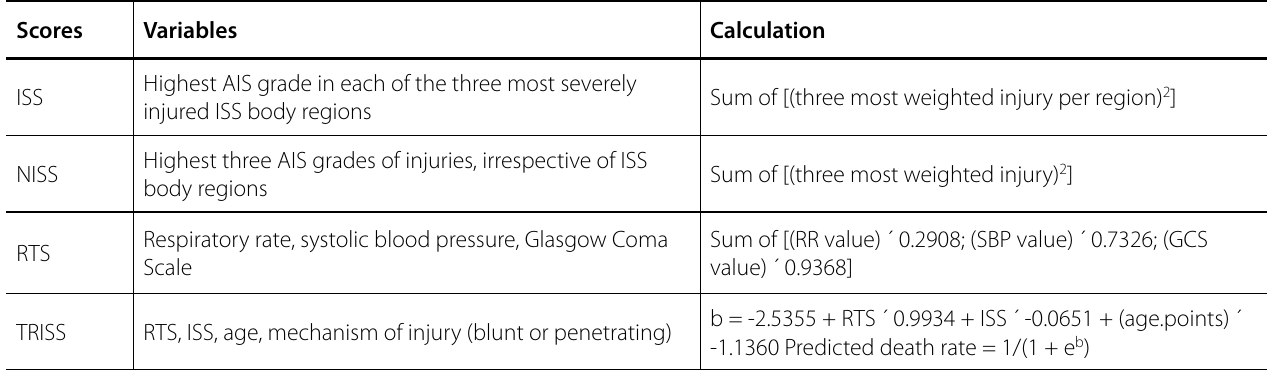
Table 1 . Variables and calculation of ISS, NISS, RTS, and